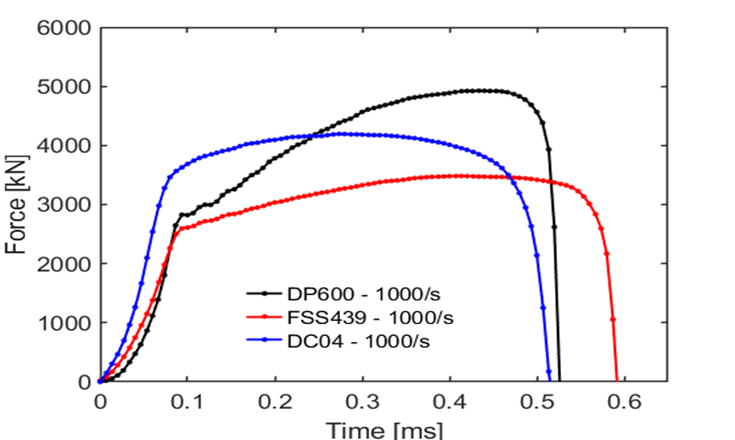
Figure 6: Force–time curve measured in EMA area of Gen. III sample for three